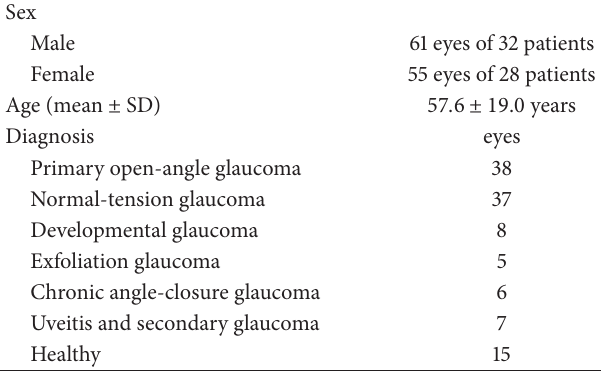
Table 1: Profiles of the study subjects (116 eyes of 60